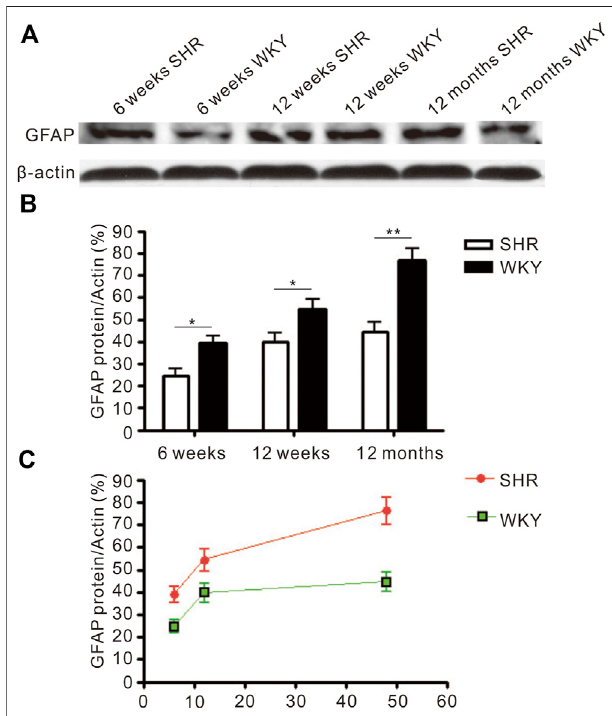
FIGURE4| ThelevelofGFAPproteinexpressedinthefrontalcortex. (A) TheWesternblotresultofGFAPinthefrontalcortexofSHRandWKY. (B) The increased expression of GFAP in the frontal cortex was more severe in the SHR than in WKY. * p < 0.05 versus age-matched WKY control, ** p < 0.01 versus age-matched WKY control. (C) The change of GFAP expression in the frontal cortex in aged process of SHR and WKY. The values represent mean ±